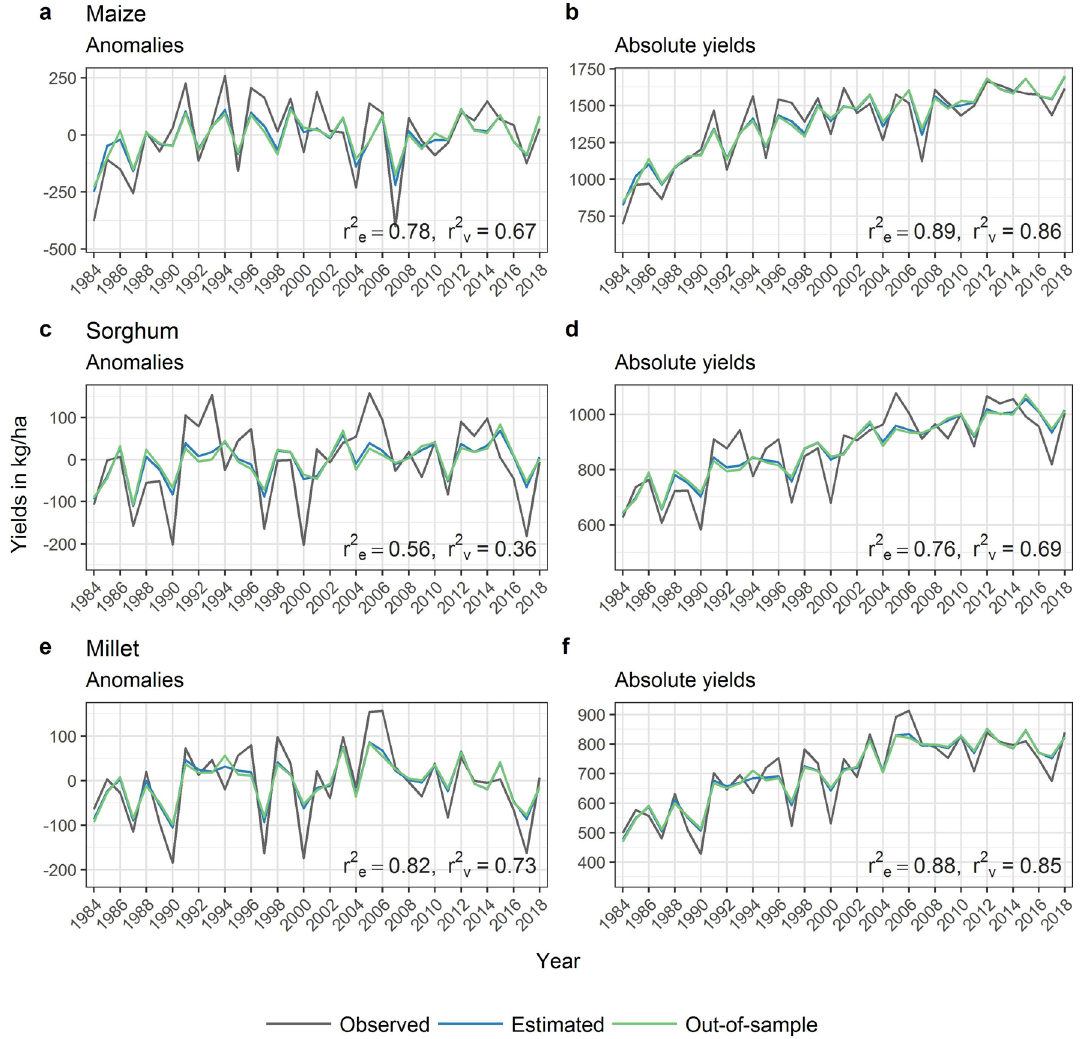
Figure 1. Crop model performance for yield anomalies (left column) and absolute yields (right column) for maize, sorghum and millet from 1984 to 2018. The plot shows the observed yields in grey, the estimation results in blue and the out-of-sample validation results in green. The r 2 e and r 2 v values indicate the explained variance by each model, respectively. The province-specific model performances are shown in SI Fig. 1, a map with province names is shown in SI Fig.